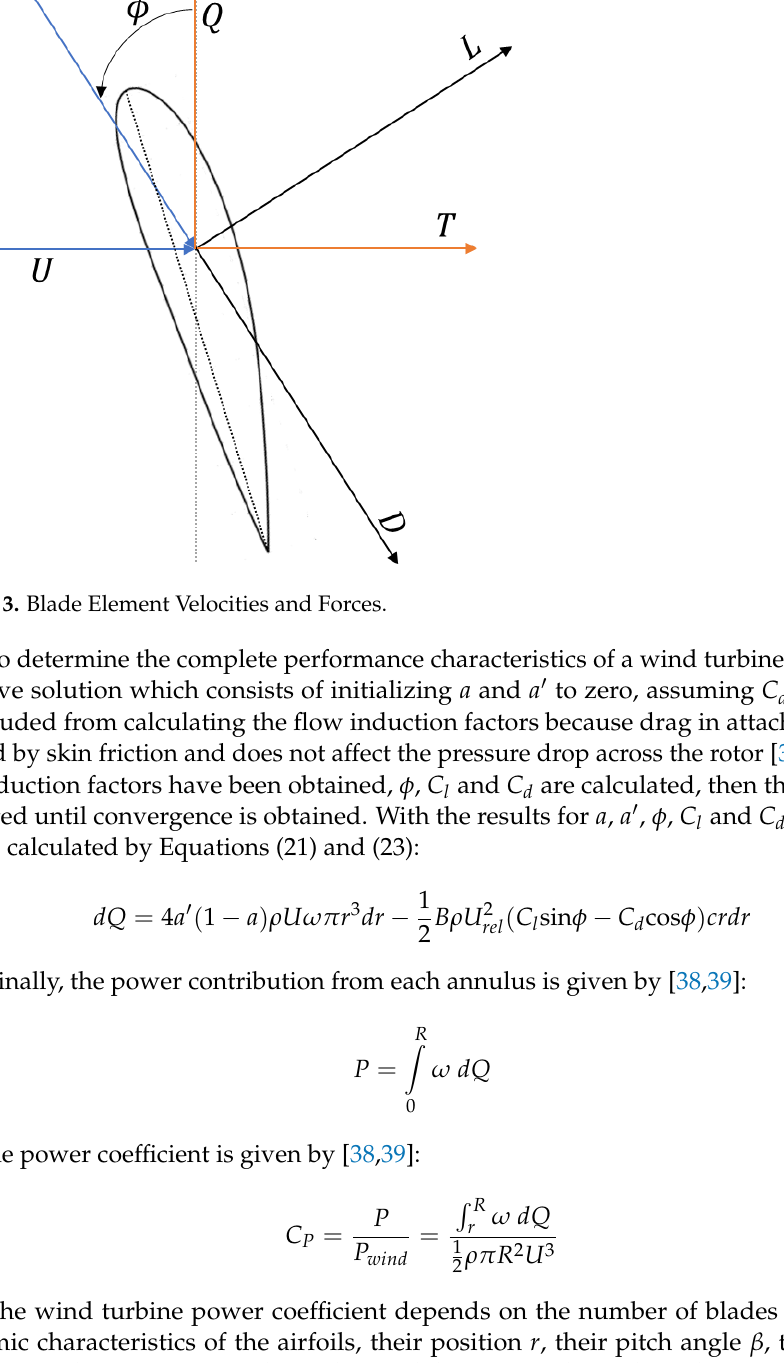
flow is unstable, generating steady and trailing vortices that cause delays in flow separa- tion, drag reduction, lift increase and, eventually, at large angles of attack, lift and drag coefficients that differ significantly from those obtained by 2D computations and meas- urements [41].